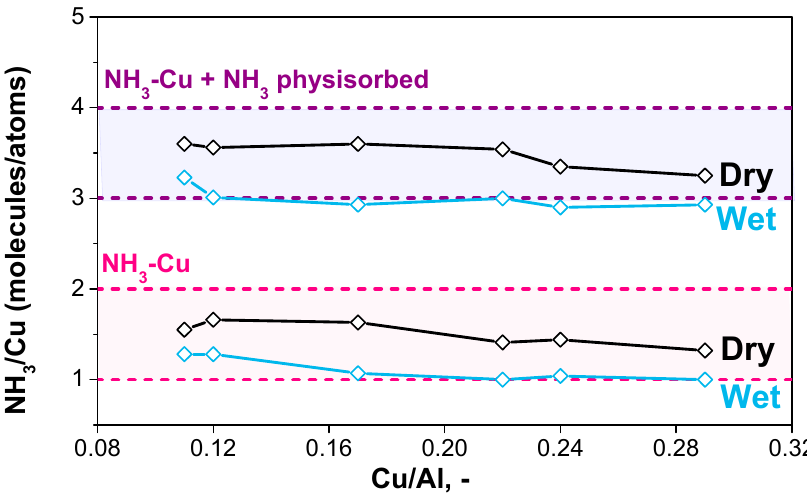
Figure 6. NH 3 /Cu ratio evaluated considering only NH 3 stored on Cu ions (low-T peak of TPD) and NH 3 stored on Cu ions plus NH 3 physisorbed: comparison between dry and wet conditions.